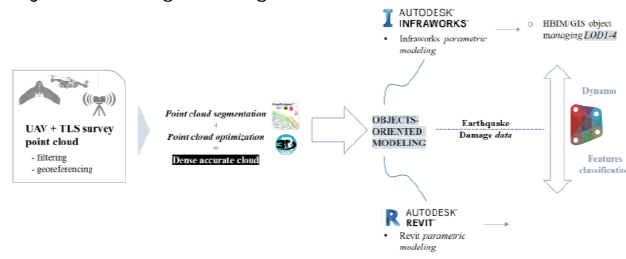
Table 1 . The main step of the HBIM modelling